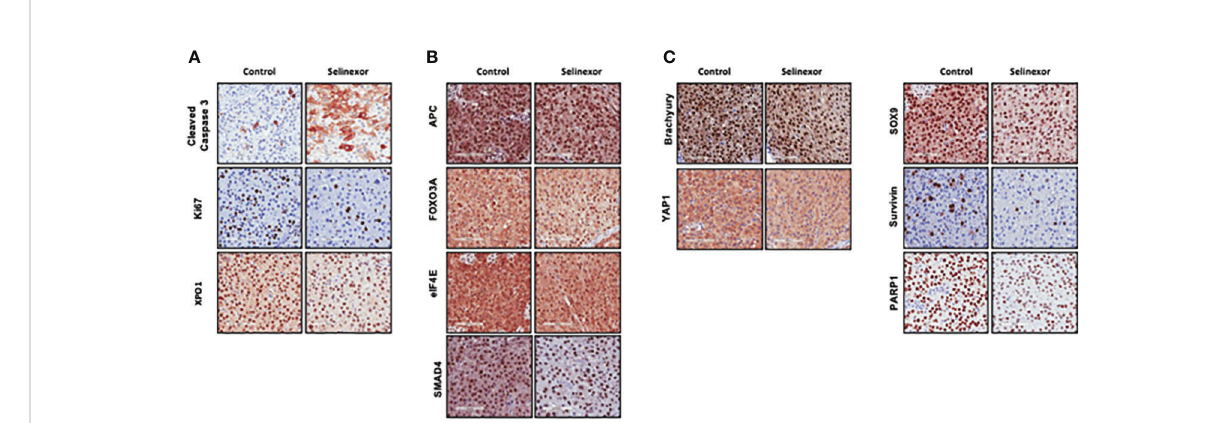
FIGURE 3 Effect of selinexor on indicators of cell health, chordoma markers, and XPO1 cargo proteins. Immunohistochemistry analysis of tumor samples from CF466 PDX models treated for six weeks with either vehicle control or selinexor. (A) Markers of cell survival (cleaved caspase 3) and proliferation (Ki67), as well as the selinexor target XPO1. (B) XPO1 cargo proteins APC, FOXO3A, eIF4E and SMAD4. (C) Proteins involved in sonic hedgehog signaling pathways such as SOX9, and YAP1, and regulators of chordoma cell growth, Brachyury and Survivin, as well as DNA repair enzyme